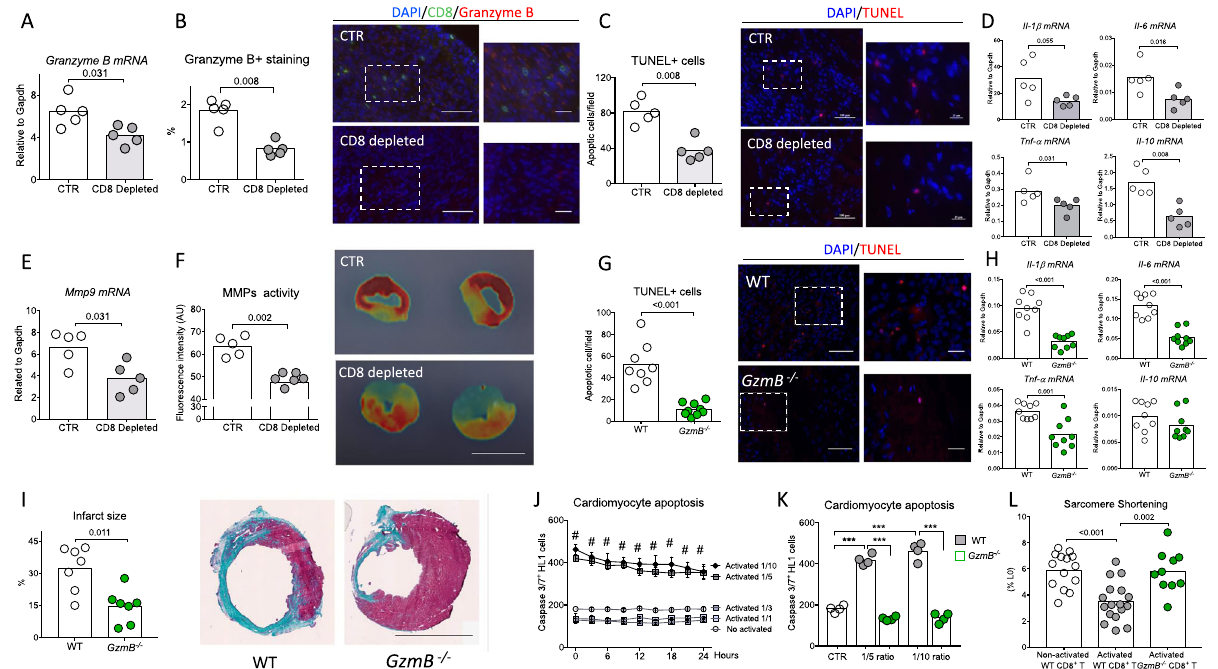
Fig. 4 CD8 + T lymphocyte depletion or Granzyme B global de fi ciency reduces cardiomyocyte apoptosis and pro-in fl ammatory responses within the ischemic heart tissue. A Representative histograms of mRNA levels of Granzyme B within the injured myocardium on day 3 after MI in CTR (white) and CD8-depleted (gray) mice ( n = 5/group). B Representative examples (right) and quantitative analysis (left) of Granzyme B staining in the ischemic heart of C57BL/6J mice with or without CD8 depletion ( n = 5/group); scale bars 50 and 25 μ m. C Representative examples (right) and quantitative analysis (left) of TUNEL + cells (Red) in the peri-infarct area of C57BL/6J mice ( n = 5/group); scale bars 50 and 25 μ m. D Representative histograms of mRNA levels of Il-1 β , I-6, Tnf- α , and Il-10 within the injured myocardium on day 7 after MI ( n = 5/group). E Representative histograms of mRNA levels of Mmp9 within the injured myocardium on day 7 after MI ( n = 5/group). F Quanti fi cation (left) and representative photomicrographs (right) of matrix metalloproteinase (MMP)-sense 680 activity in the ischemic heart measured by ex vivo re fl ectance epi fl uorescence imaging at day 7 (CTR n = 5 and CD8 depleted n = 6), scale bar 2.5 mm. G Acute MI was induced on C57bl6 wild-type (WT, white) mice or Granzyme B de fi cient ( GzmB − / − , green)